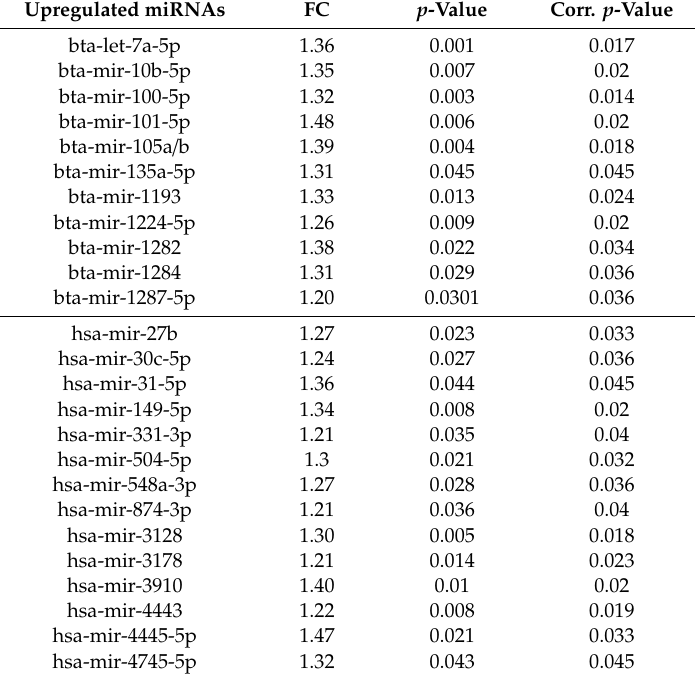
Table 1. Di ff erentially expressed miRNAs (DE miRNAs) in bulls with high intramuscular fat